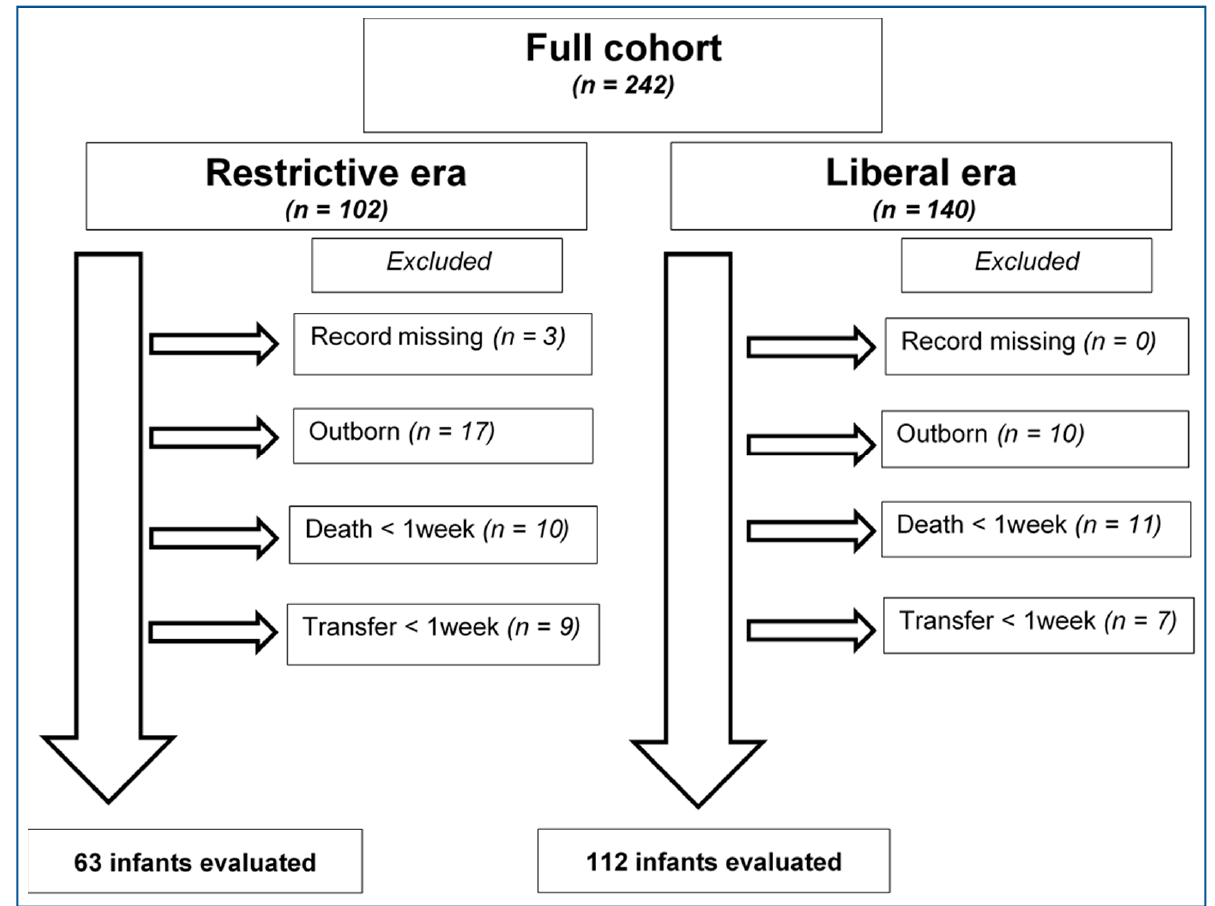
Figure 1. Included and excluded infants in the study cohort.